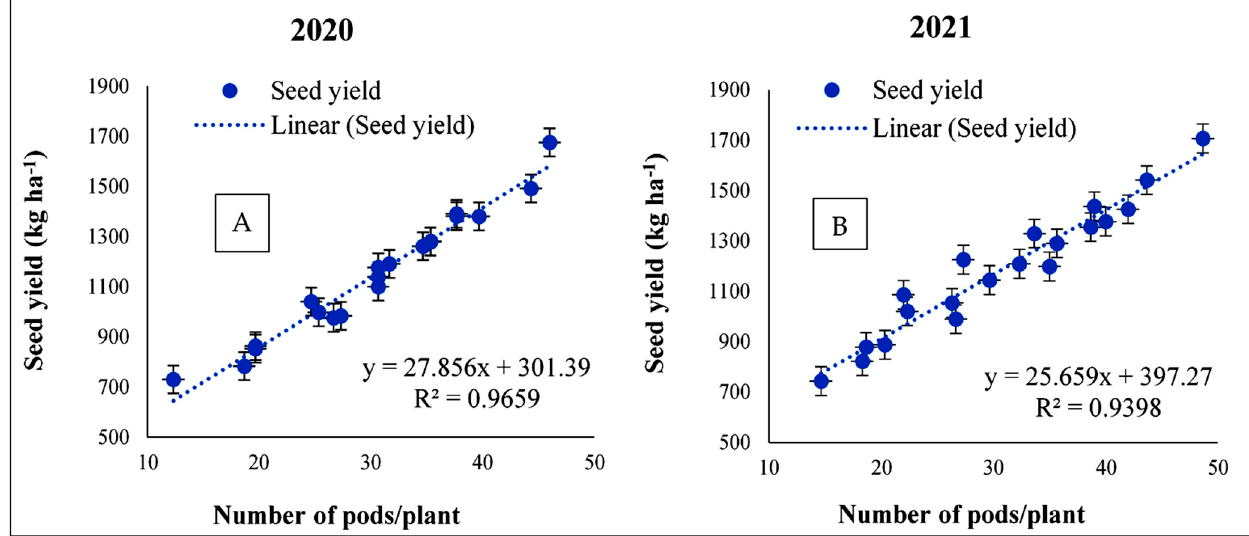
Figure 5. Impact of the number of pods per plant on seed yield of black gram during crop season: ( A ) 2020 and ( B ) 2021 (error bars are representing the standard error of the mean.).